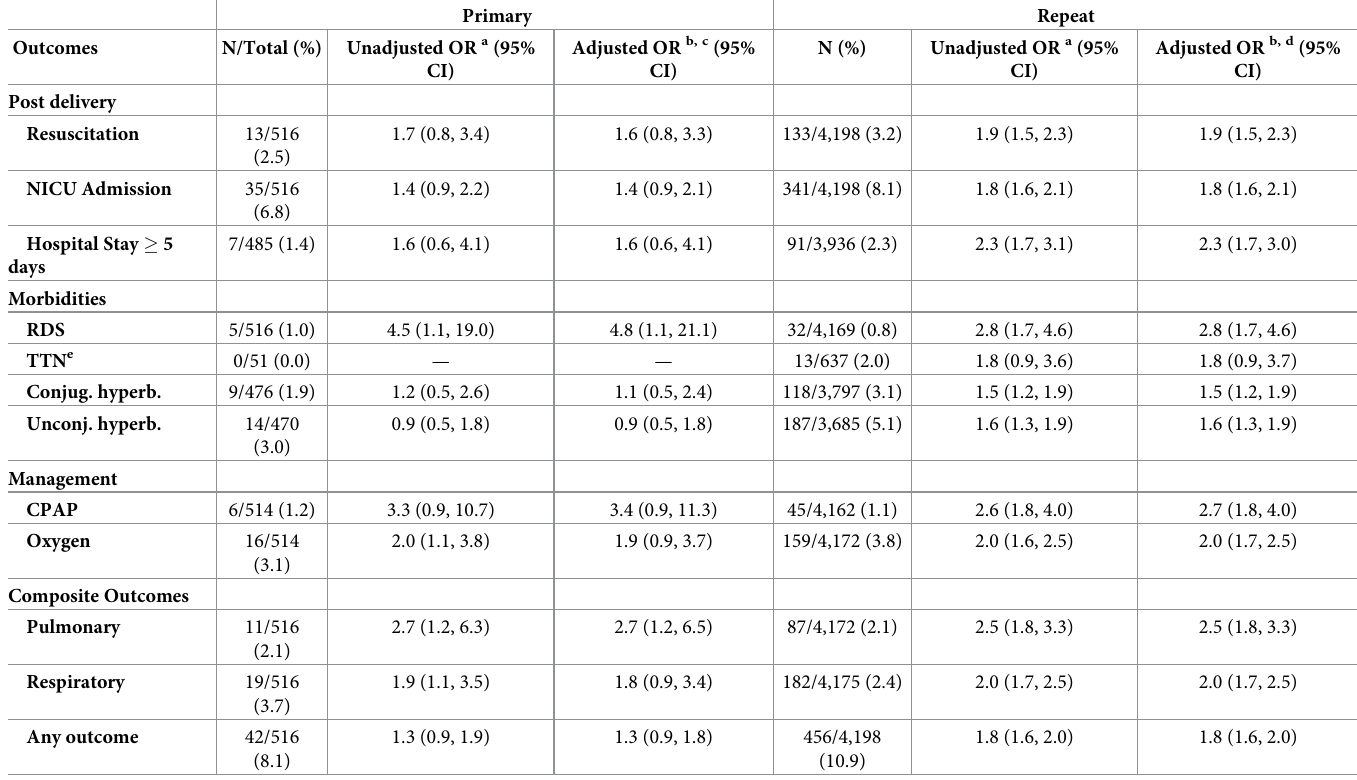
Table 4. Unadjusted and adjusted ORs for adverse neonatal outcomes at 37 compared to 38 weeks of gestation among women with primary or repeat